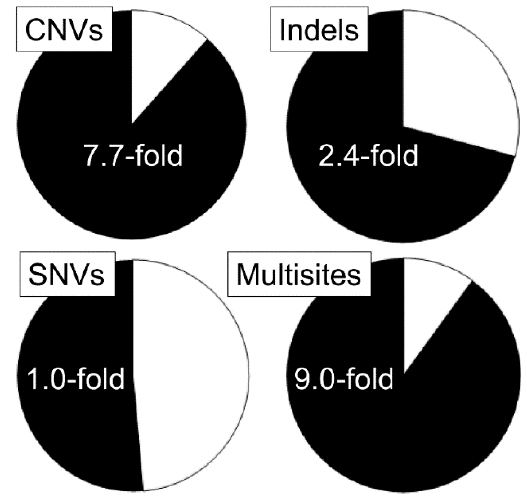
Figure 2. De novo mutation frequencies in the mouse germline established by the whole-genome comparative hybridization and next-generation sequencing. The frequency of de novo mutations per offspring of control (white) and irradiated males (black) are shown. Data from Reference [42].